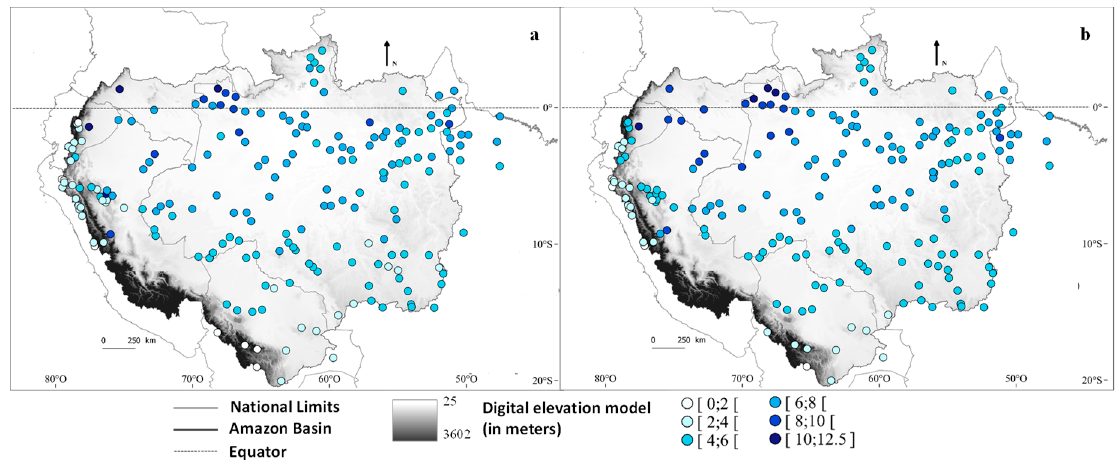
Figure 3. Spatial distribution of ( a ) mean daily rainfall per rain gauge ( b ) mean daily rainfall in the nearest pixel 3B42 of the rain gauge. Both are expressed in millimeters per day. The average is computed on the 1998–2013 period.